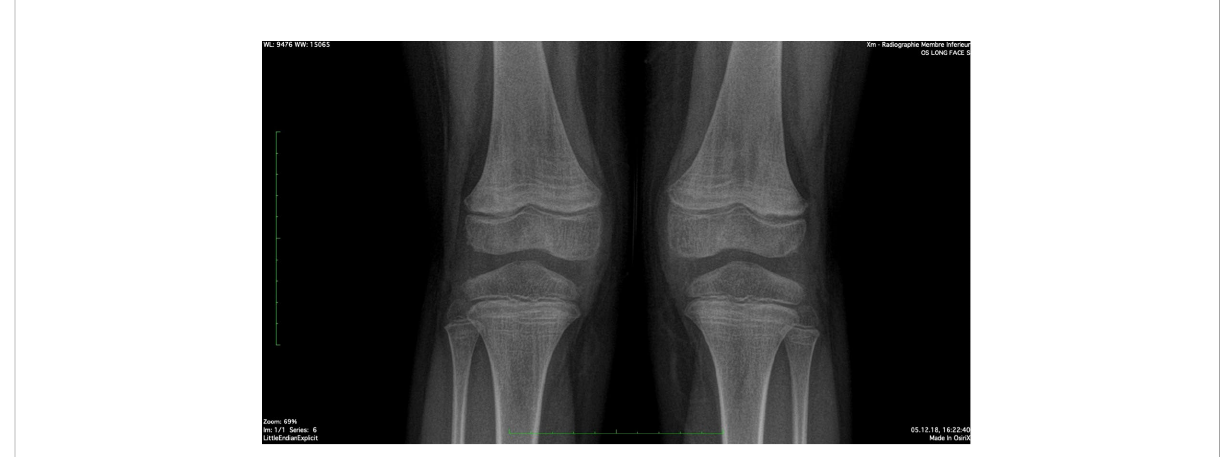
FIGURE 2 Harris Lines are visible as radiopaque transverse lines located in the metaphyses of the long bones (femur and tibia in this picture). These lines are the result of growth arrest periods, but can also be seen in cases of heavy metal